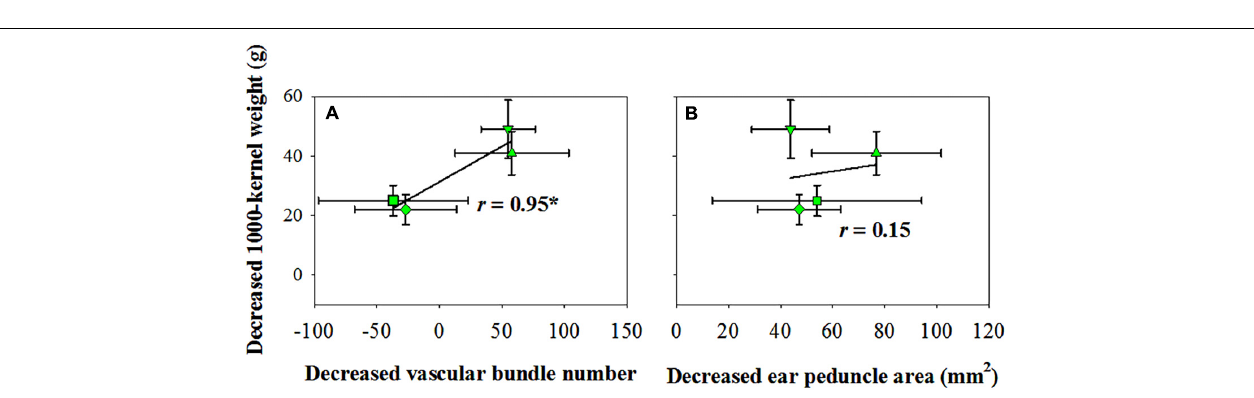
FIGURE 4 | Correlation of kernel number reduction with vascular bundle number reduction (A) and ear peduncle area reduction (B) in 2016. CK, well-irrigated treatment; V 6 − 8 , water deficit during the 6–8-leaf stage; V 9 − 12 , water deficit during the 9–12-leaf stage; V 13 − T , water deficit from the 13-leaf stage to tasseling stage,